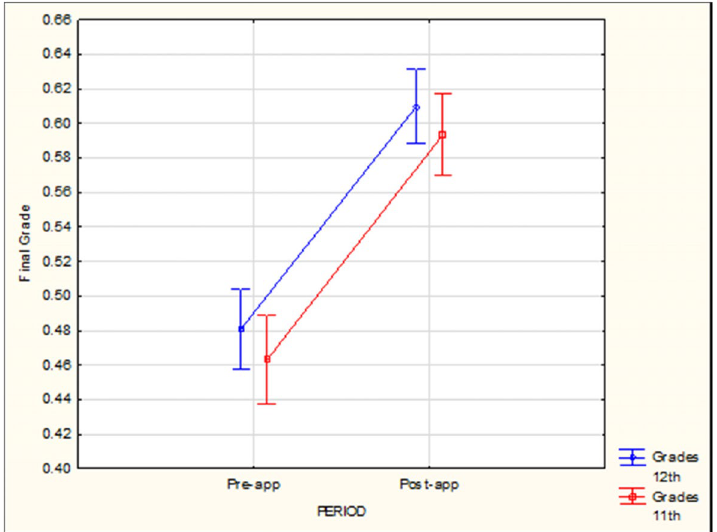
Fig. 4 Multifactorial dispersive analysis of the index Final Grade (factors: grades,